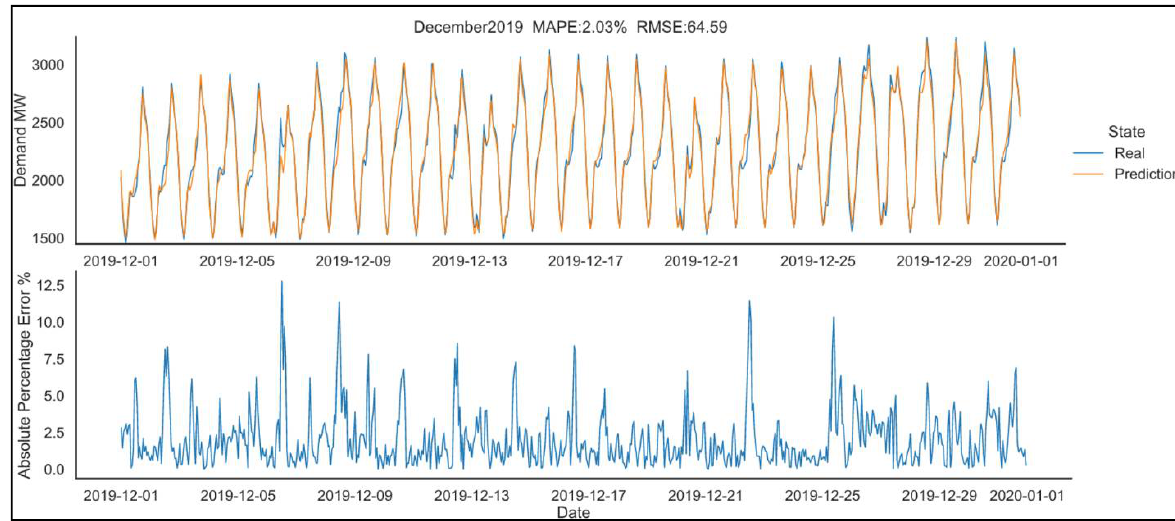
Figure 13. December-2019 prediction results.